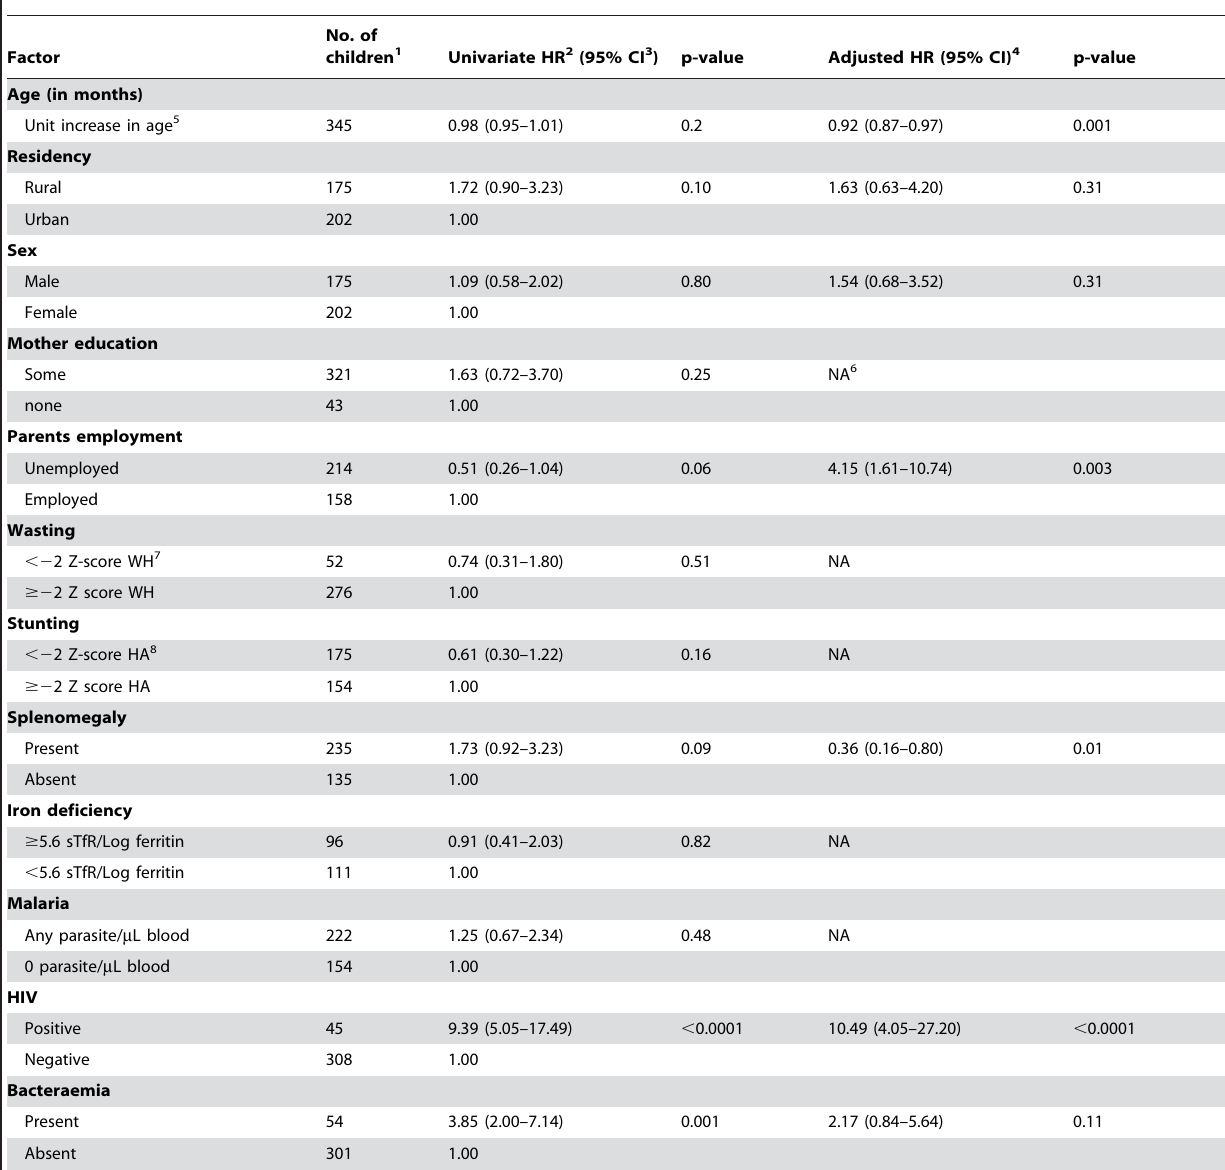
Table 4. Risk factors for post-discharge all cause mortality among